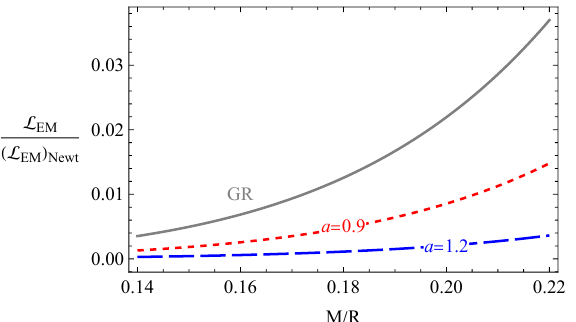
Figure 9. Normalized values of the magnito-dipolar radiation luminosity to its Newtonian value for different values of the EU